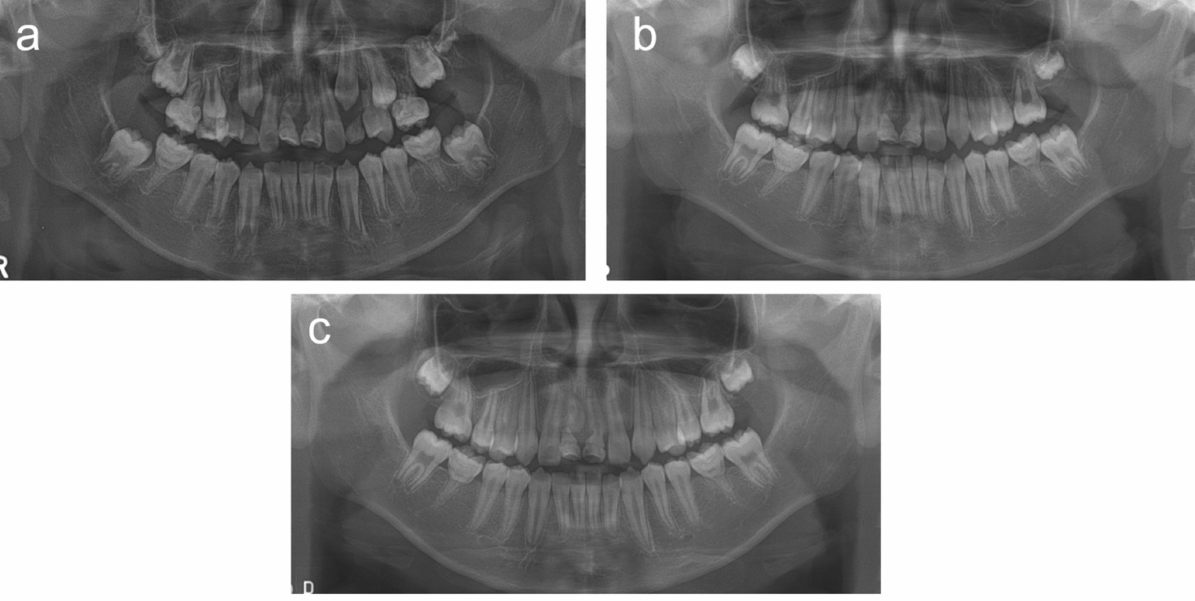
Figure 3. Panoramic radiographs of patient 2. ( a ) Panoramic radiograph at age 9 years 7 months. ( b ) Panoramic radiograph at age 10 years 10 months. ( c ) Panoramic radiograph at age 11 years 8